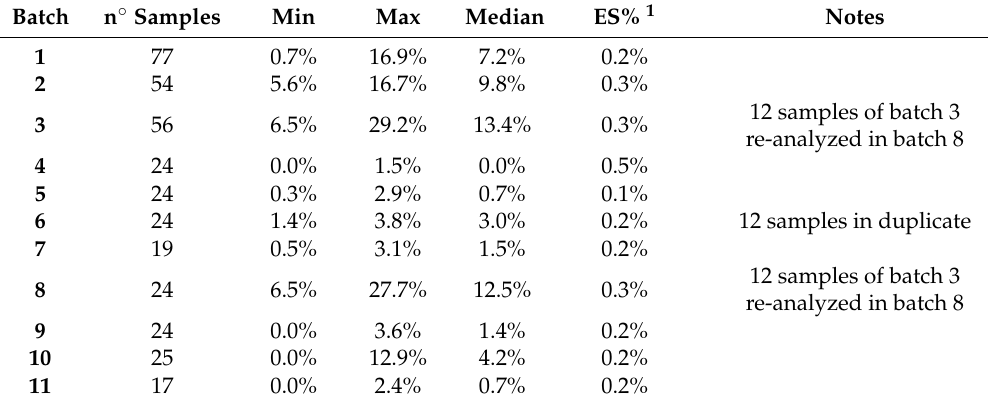
Table 3. Summary of the results from the measurement of glutathionyl hemoglobin in 11 batches of RBCs.